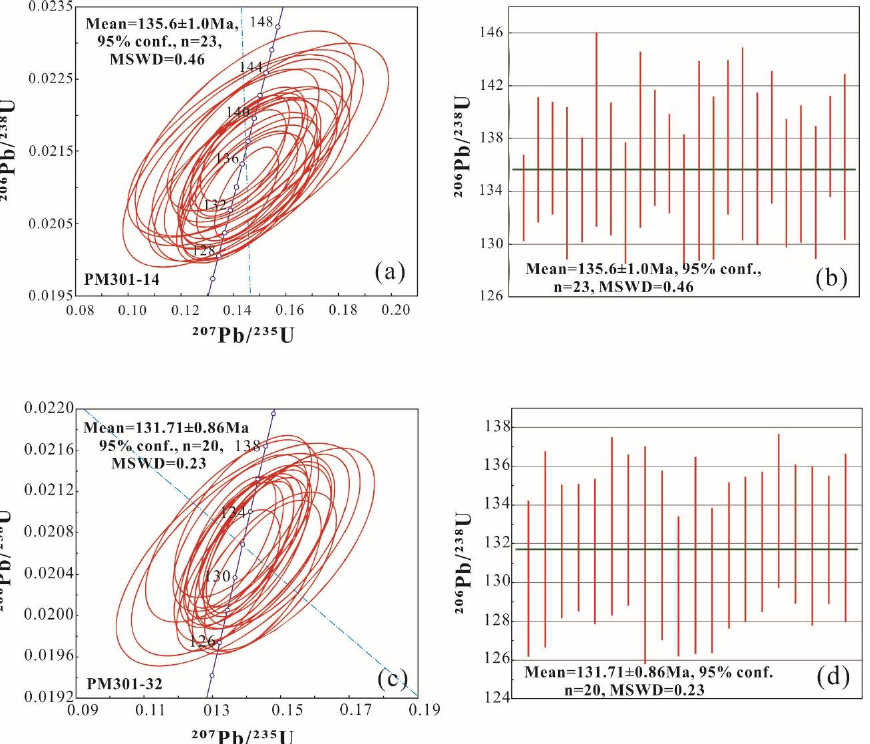
Figure 6. In situ analytical results of zircon U-Pb age by LA-ICP-MS, ( a , b ) concordia ages and their weighted average age of rhyolitic tuff sample PM302-14, ( c , d ) concordia ages and their weighted average age of rhyolitic tuff sample PM302-32.